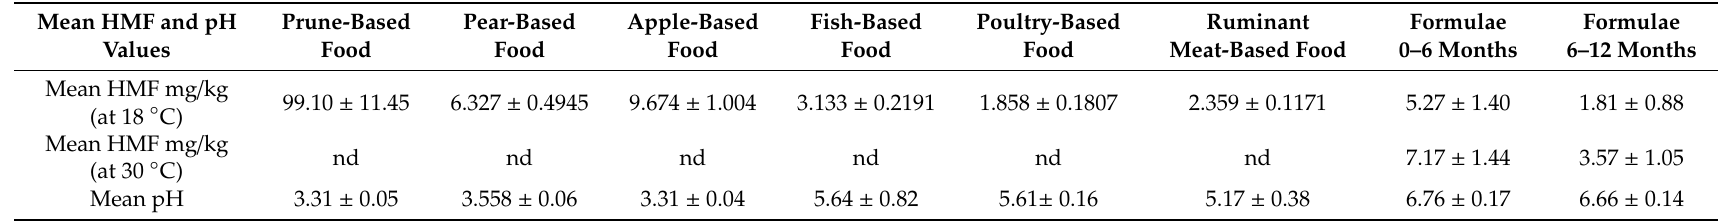
Table 2. HMF content (mg / kg) and pH of infant foods and formulae.